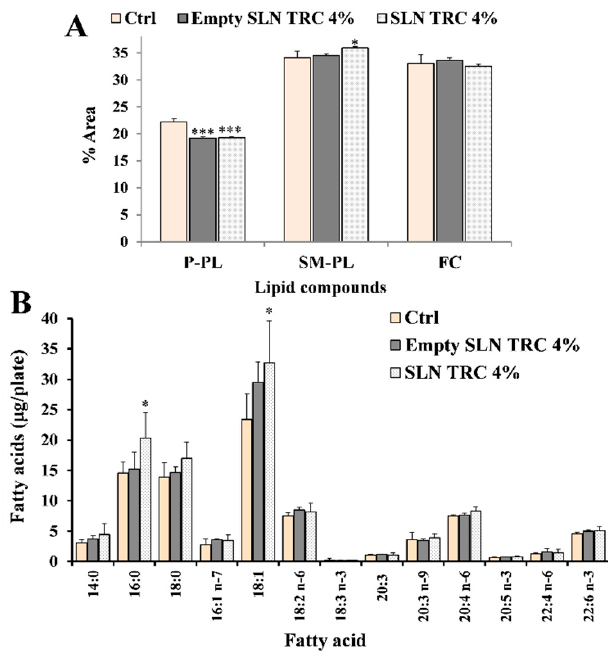
Figure 7. Values of lipid compounds (saturated / monounsaturated phospholipids, S / M–PL; polyunsaturated phospholipids, P-PL; free cholesterol, FC) (% area) ( A ) and the main fatty acids (expressed as µ g / plate) ( B ) measured in control 3T3 (Ctrl) and fibroblasts treated for 24 h with unloaded (empty SLN TRC 4%) and 8-MOP-loaded (SLN TRC 4%) SLN with 4% TRC. Two independent experiments and tree replicates for each condition are performed and data are presented as mean ± SD ( n = 6); *** = p < 0.001; * = p < 0.05 versus Ctrl (One–way ANOVA followed by the Bonferroni Multiple Comparisons Test).